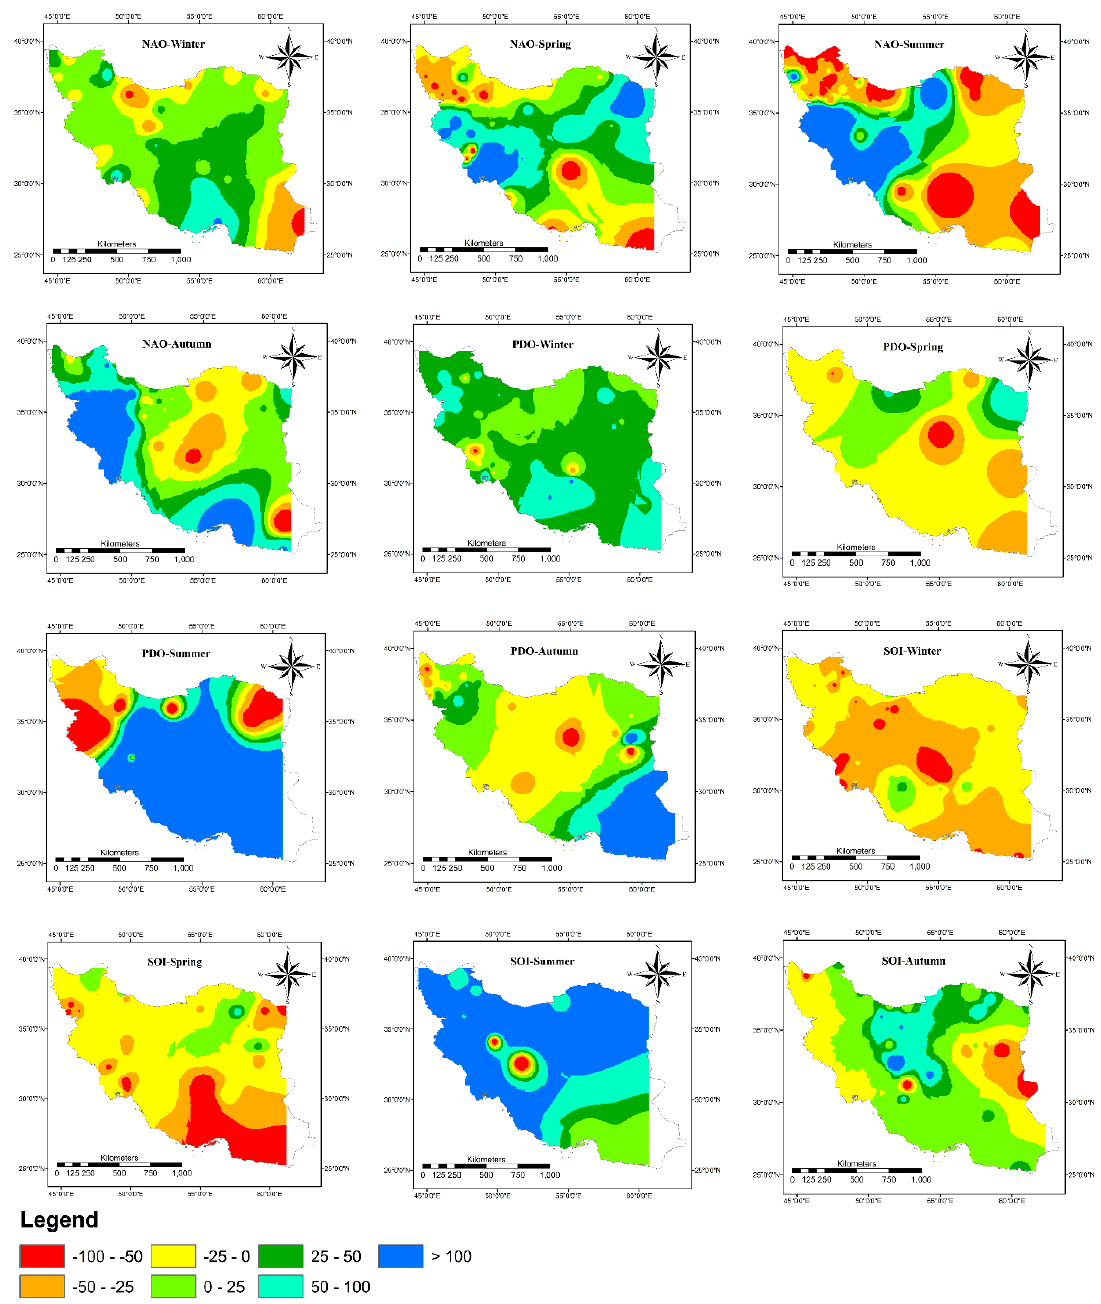
Figure 10. Total change in precipitation due to the e ff ect of SOI, NAO, and PDO in the range of x < 2, where x denotes the SOI, NAO, and PDO value.